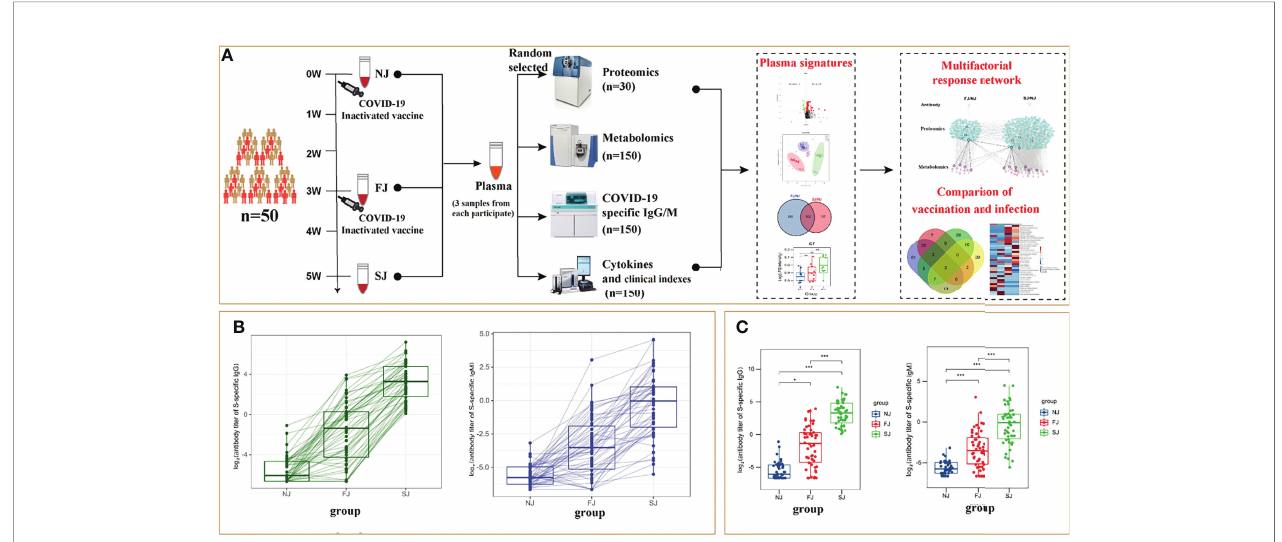
FIGURE 1 | CoronaVac Study Overview and Antibody Expression. (A) Study overview. Fifty subjects were recruited. Different samples of each subject were taken at NJ (baseline, day 0), FJ (about 21 days after fi rst immunization) and SJ (about 14 days after second immunization). Plasma proteomics, metabolomics, SARS-CoV- 2-S-speci fi c antibody titers, cytokines and clinical parameters were analyzed to construct an integrated network. (B) Representative SARS-CoV-2 S-speci fi c IgG and IgM in each subject. (C) Average levels of SARS-CoV-2 S-speci fi c IgG and IgM in each group. The Y-axis labels of Figure (B , C) were Log 2 (antibody titer of S- speci fi c IgG or IgM). Statistical signi fi cance was determined by two-sided paired Welch ’ s t test. *p < 0.05; ***p <